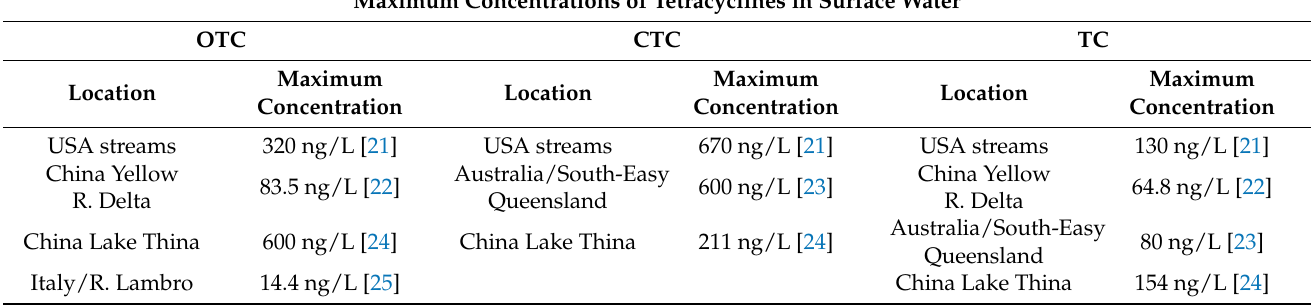
Table 1. Maximum concentrations of tetracyclines in surface